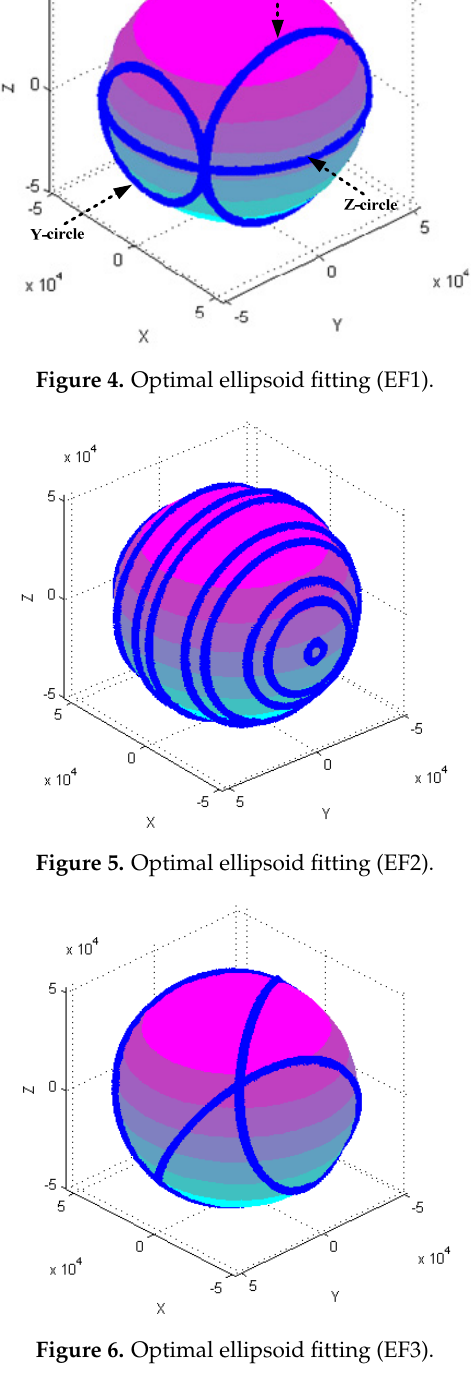
Figure 8. Optimal ellipsoid fitting (EF5). Figure 9. Optimal ellipsoid fitting (EF6). Figure 10. Optimal ellipsoid fitting (EF7). Figure 11. Optimal ellipsoid fitting (EF8). Table 2 shows the calibration results. It can be seen that magnetometers can be calibrated by four different attitude changes. In case1, the ellipsoid fitting results correspond to the EF1–EF4. Where, there are minimal estimation errors in EF4. On the contrary, the EF1 has maximal estimation errors. In the case 2, the ellipsoidal fitting results show in Figure 8–11. Because the magnetometer have large error parameters, the ellipsoid fitting results (EF5–EF8) are obviously different from case